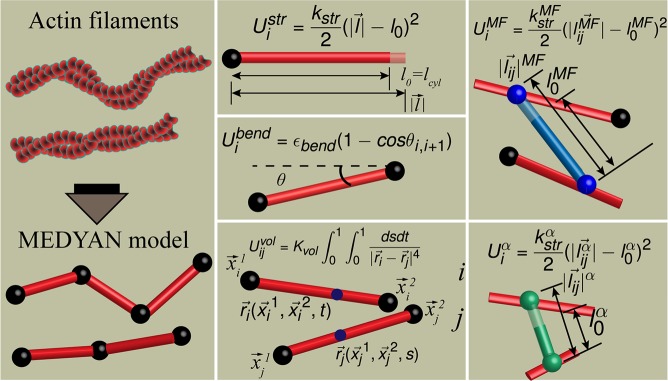
The mechanical model of actin, α-actinin and myosin minifilaments in MEDYAN.Double helix structure of actin filament is represented as a series of cylinders (red) connected together at hinges (black spheres). Stretching (Uistr), bending (Uibend) and cylinder-cylinder excluded volume (Uijvol) interactions are elaborated. Crosslinkers (green) and myosin MF (blue) experience stretching potentials (Uiα and UiMF respectively). More details are provided in the Methods section and the Supporting Methods (section 2 in S1 Text).